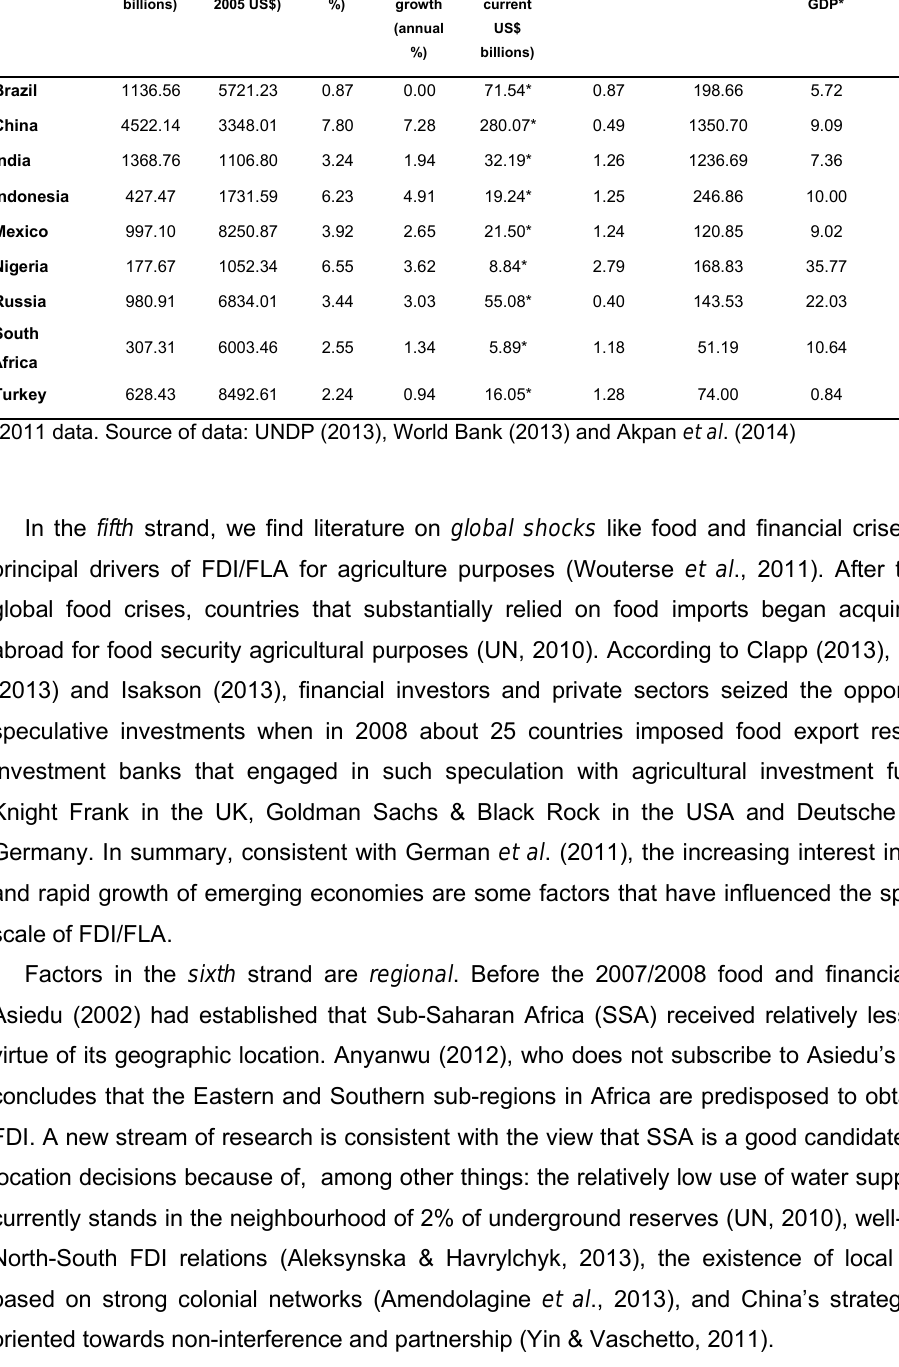
Population, total, millions